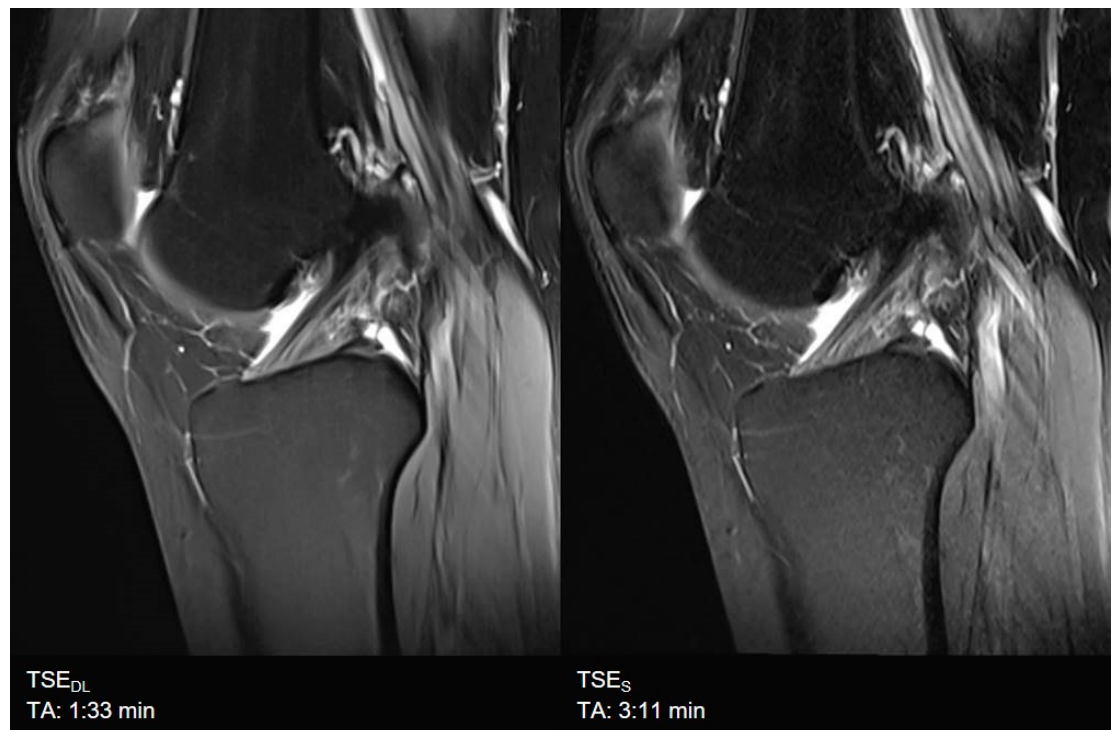
Figure 3. Example of a Deep Learning and standard PD-weighted turbo spin echo (TSE) image of the knee in sagittal orientation. Note that the extent of noise in TSE DL ( left ) is distinctly reduced compared to TSE S ( right ), which comes with the fact that, at the same time, very small structures such as small bone channels disappear. The visibility of anatomic relevant structures is not impaired.